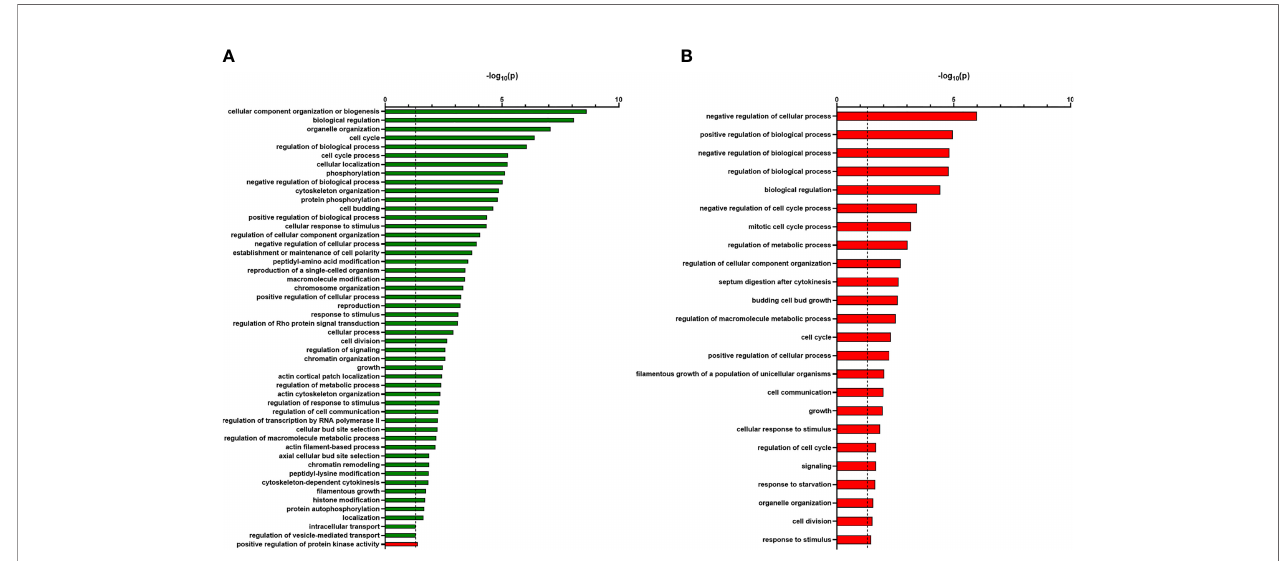
FIGURE 6 | GO term analysis shows a different pattern of biological processes of the less and more abundant identi fi ed phosphoproteins of Ca sky1 D versus wild type and Ca sky2 D versus wild type. (A, B) GO terms of all identi fi ed phosphoproteins that were signi fi cantly more (green bars) or less abundant (red bars) in the Ca sky1 D mutant compared to the wild-type strain SC5314 (A) and in the Ca sky2 D mutant compared to the wild-type strain SC5314 (B) were analyzed using the GO term fi nder (CGD) and ‘ process ’ as a query and then using the Revigo tool (http://revigo.irb.hr/). Only signi fi cant GO terms de fi ned by -log 10 (0.05) are shown (indicated by dashed line at 1.3 on X axis).